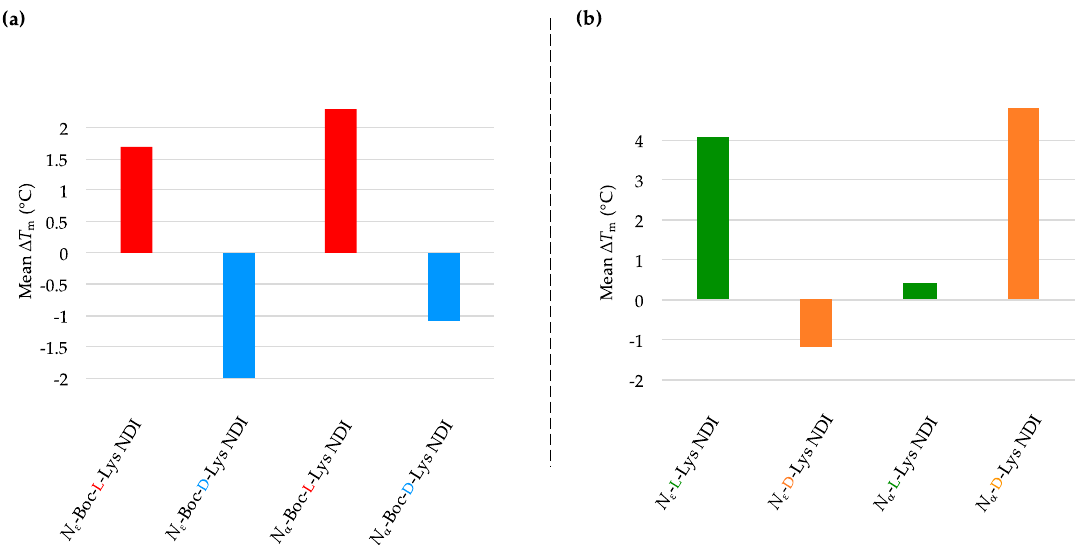
Figure 5. Graphical representations of mean ∆ T m values obtained from VT CD studies of k-RAS with 10 equivalents of ( a ) N α - and N ε -Boc- L - and D -NDIs as well as ( b ) N α - and N ε - L - and D -NDIs. Table 3. The T m values of k-RAS only compared to the T m of ( a ) k-RAS-Boc-protected-NDIs and ( b ) k-RAS-deprotected-NDIs as determined from VT CD studies.